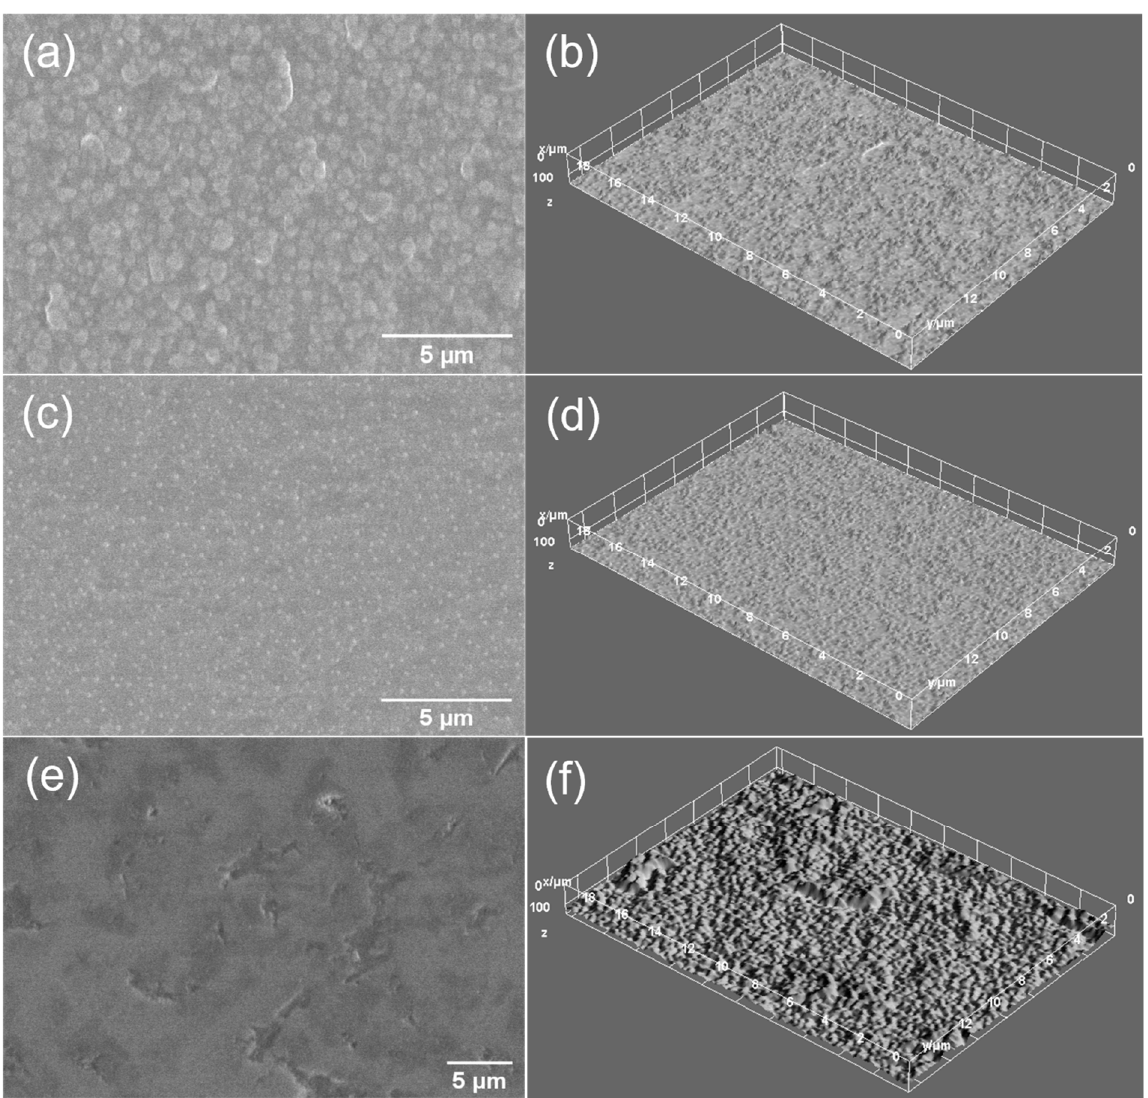
Figure 14. SEM images of ( a ) CaP_1, ( c ) CaP_2, ( e ) CaP_3 samples. 3D surface plots of ( b ) CaP_1, ( d ) CaP_2, ( f ) CaP_3 samples.